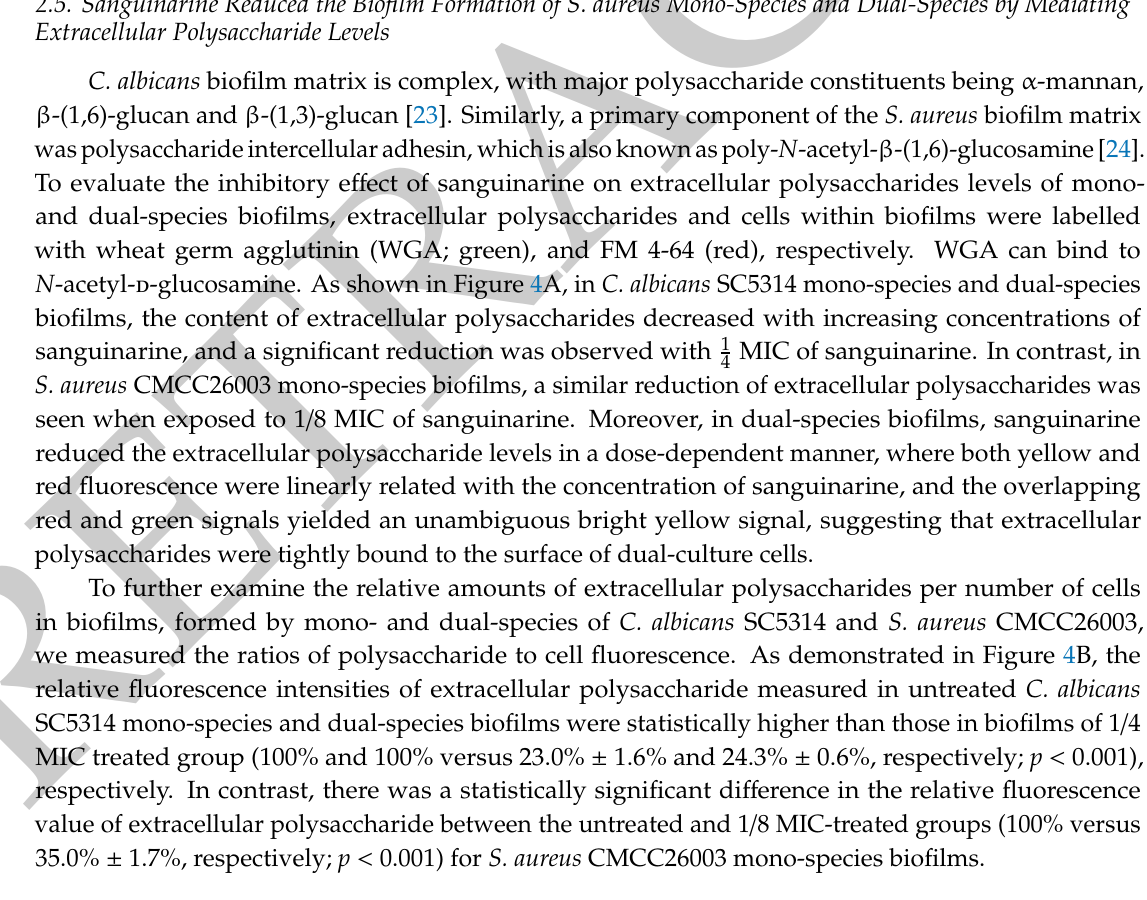
Figure 3. Evaluation of the effect of sub-MIC sanguinarine on C. albicans SC5314 (CA) and S. aureus CMCC26003 (SA) and dual-species (SA + CA) biofilm matrix structure by confocal laser scanning microscopy. ( A ) Extracellular proteins were stained with a red fluorescent stain SYPRO Ruby, and cells were stained with a green-fluorescent nucleic acid counterstain STYO 9. Scale bars represent 10 µ m. ( B ) The median fluorescence intensity of extracellular proteins in biofilms of each treatment group was determined and plotted against that in untreated group by measuring red / green fluorescence ratios using KS 400 version 3.0 software. Bars represent the standard deviation (N = 6). *** p < 0.001.